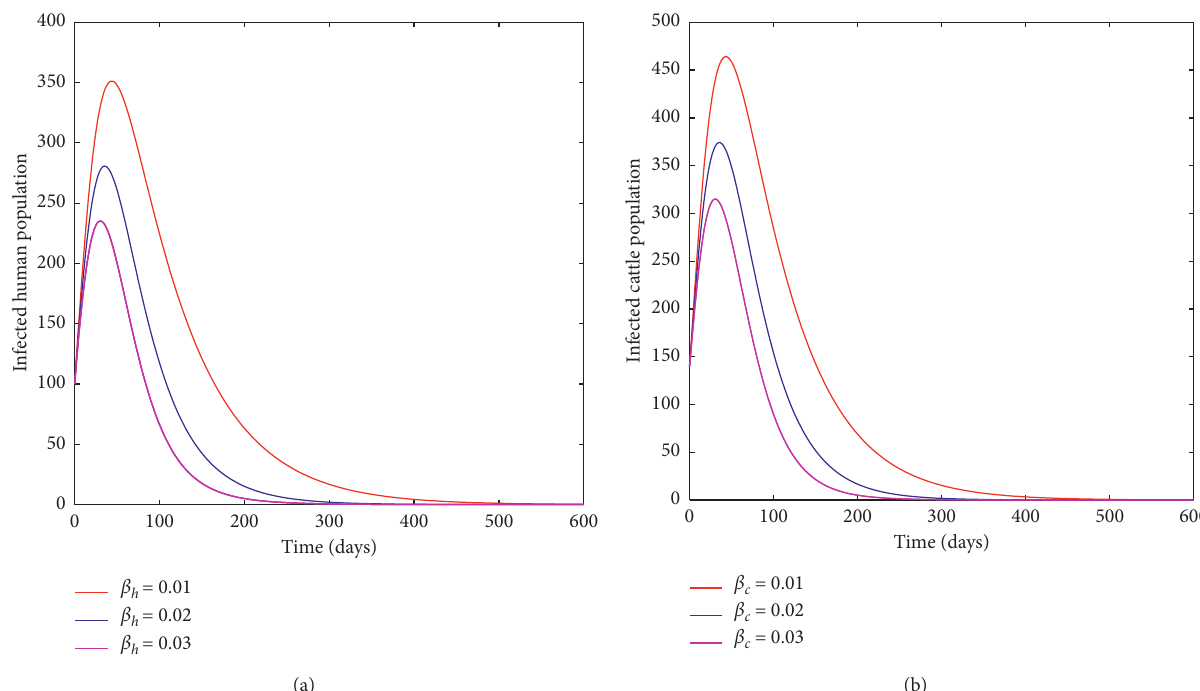
Figure 5: Variation in treatment rate on infected human and cattle